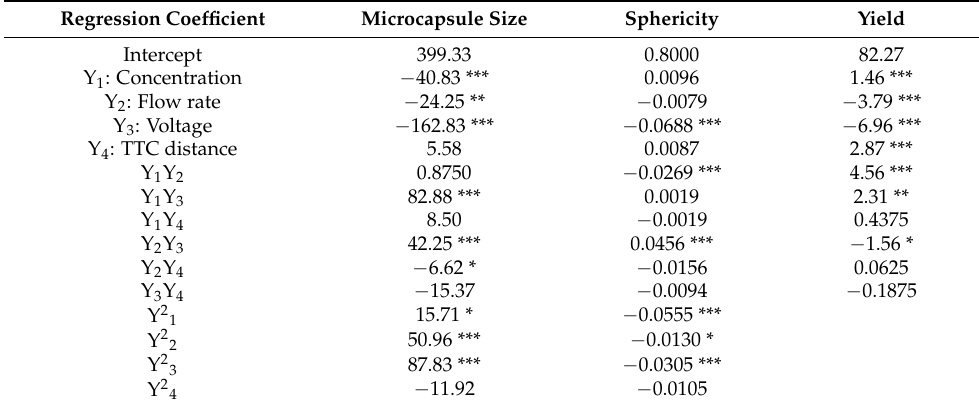
Table 6. Regression coefficient values for chitosan microcapsules. Regression